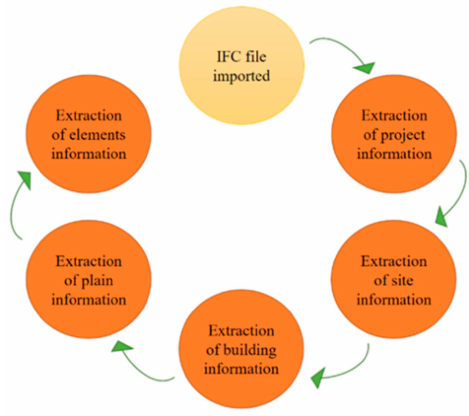
Figure 1. Extraction process of